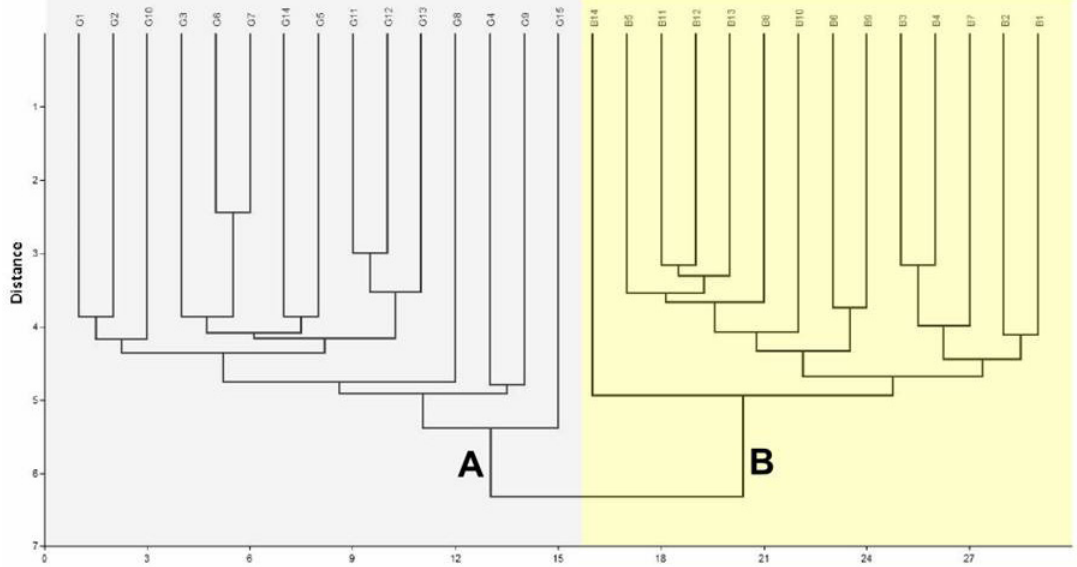
Fig 4 . Dendrogram UPGMA based on ISSR markers. Cophenetic correlation index: 0.97. A: population of M. quadrifasciata from the semiarid Region (Caatinga). B: population of M. quadrifasciata found in coconut palms of the mouth of river São Francisco, coastal area of Brejo Grande, Sergipe.